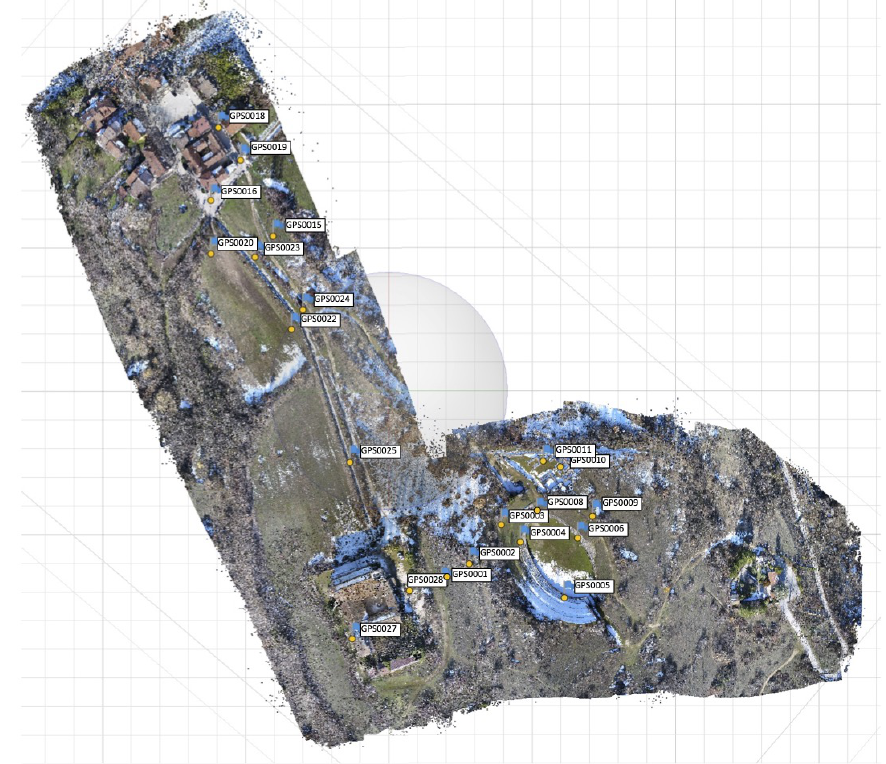
Figure 7. Dense Point Cloud generation into Agisoft Metashape and position of